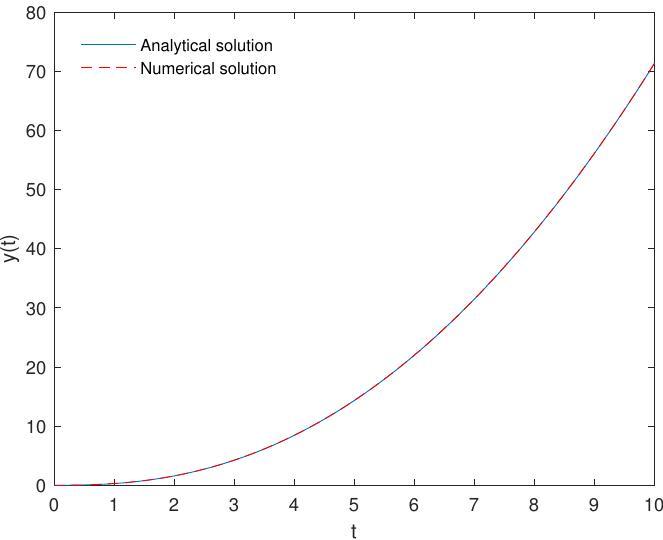
Figure 2. The time domain response of IFOTF